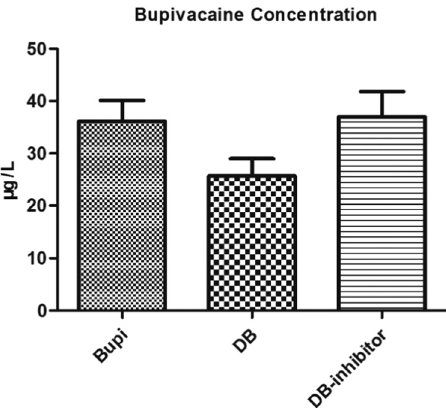
Figure 2: Bupivacaine concentration in Transwell lower chamber at 2 h. Bupivacaine concentration in DB group was signi fi cantly lower than that in other two groups ( Bupi vs DB, P = 0.002, DB - inhibitor vs DB, P = 0.001 ) . There was no statistical di ff erence between Bupi group and DB inhibitor group ( P = 0.751 ) . * P < 0.05 vs DB